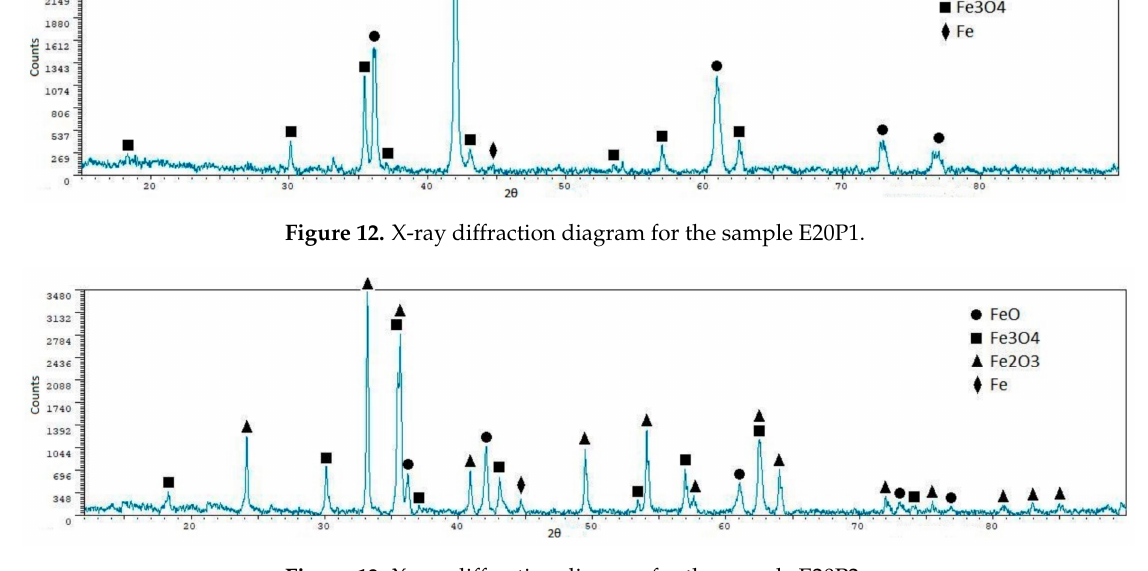
Figure 13. X-ray diffraction diagram for the sample E20P2.